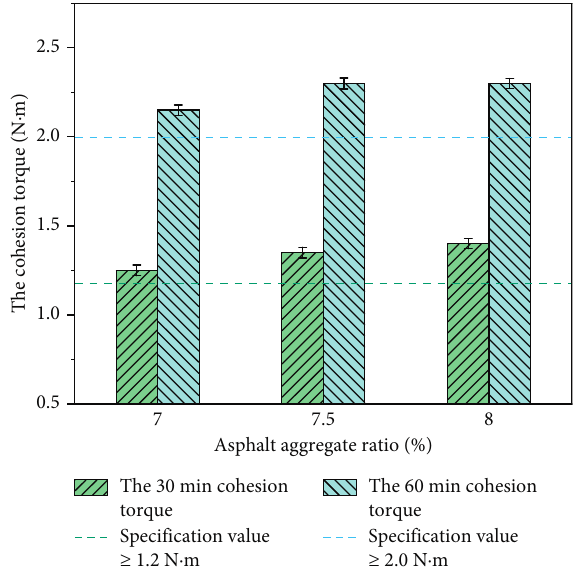
Figure 3: The cohesion torque under different asphalt aggregate ratio.